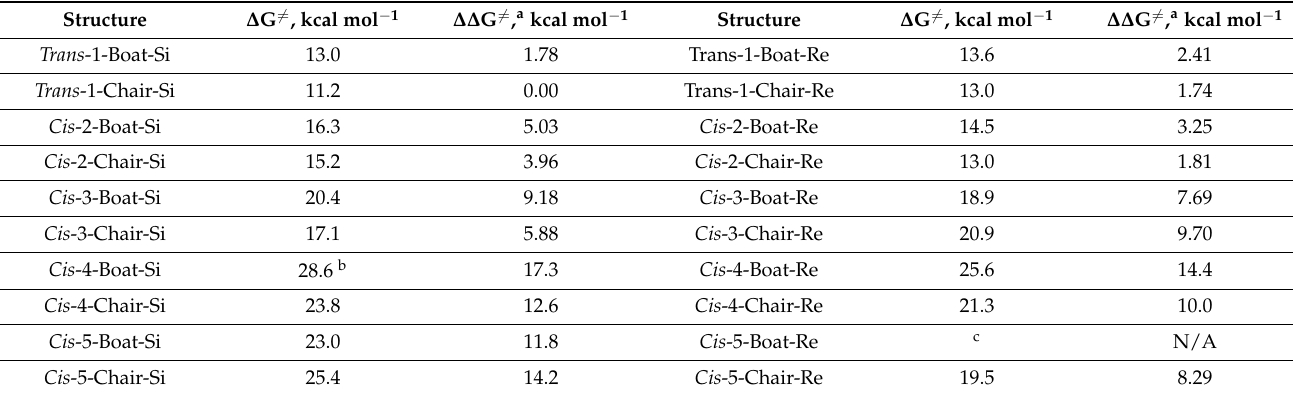
Table 1. Gibbs free energy differences calculated with respect to the reactants (second and fifth columns) and relative Gibbs free energy differences calculated with respect to the lowest-lying structure, Trans -1-Chair-Si (third and sixth column) for every TS involved in the reaction of allyltrichlorosilane and naphtaldehyde. All values are in kcal mol − 1 .